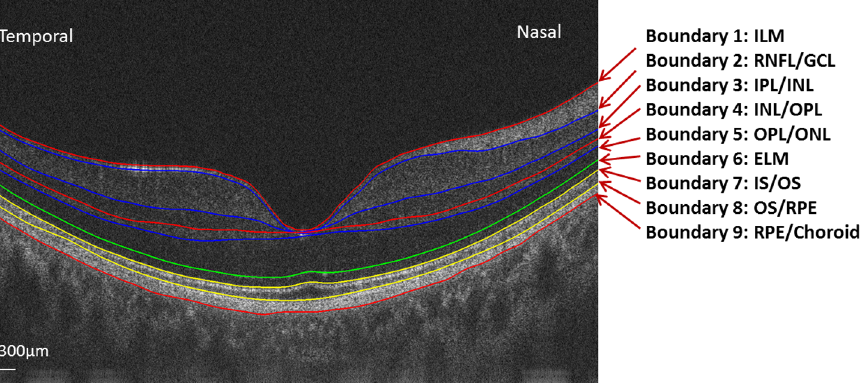
Figure 1. Boundaries of intra-retinal layers in OCT macular images. As seen in this image taken by UHR-OCT in the horizontal meridian, nine boundaries of intra-retinal layers were visualized. Images taken in the vertical meridian by UHR-OCT and in both meridians by the RTVue100 were similar to this.